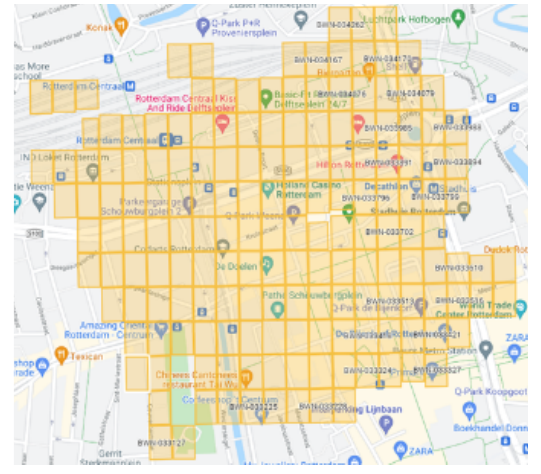
Figure 7 . MLS data of the study area